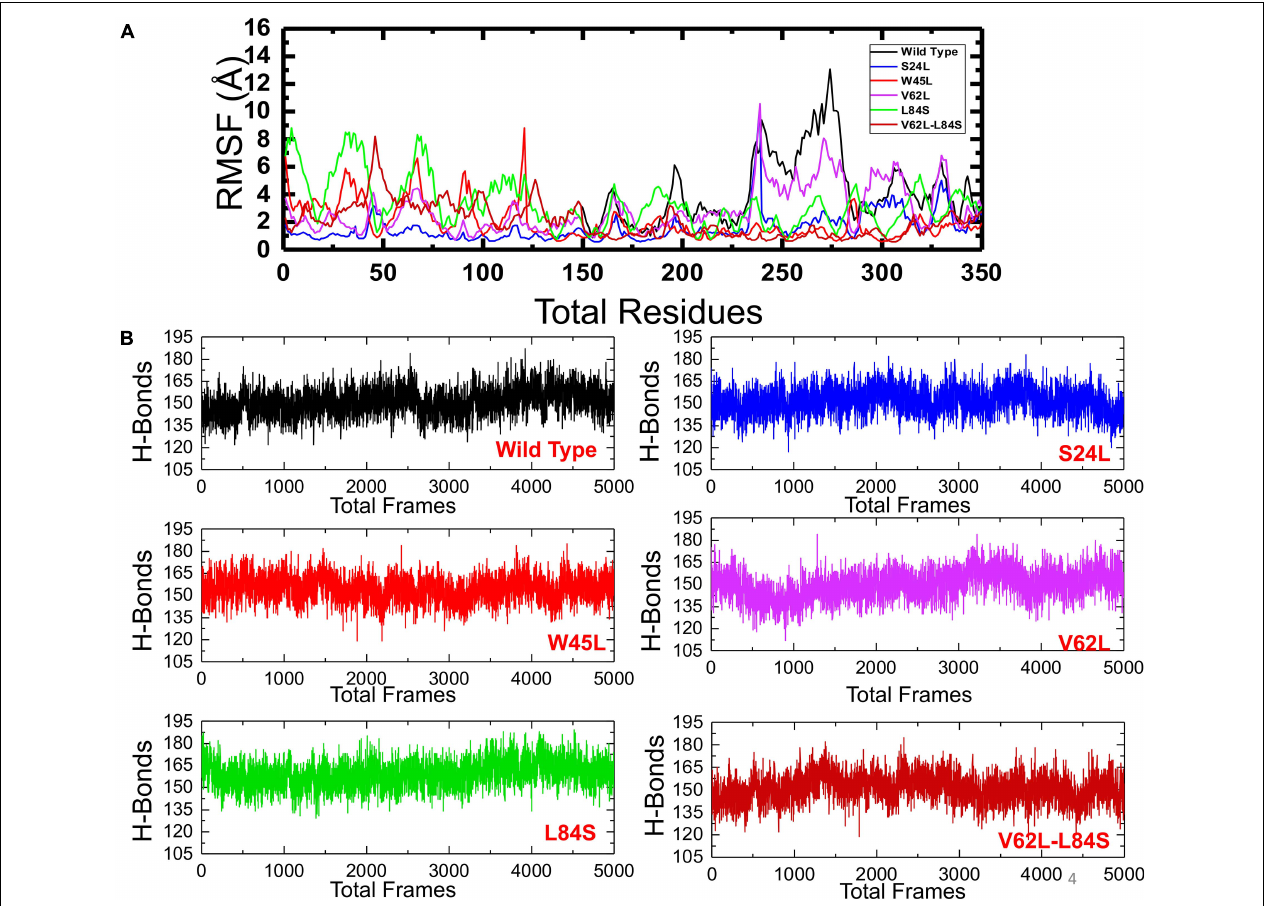
FIGURE 5 | The RMSFs and H-bonding graphs of all complexes. (A) The RMSFs of the ORF8 WT were shown in black, while the other mutants were given in different colors. RMSFs, root mean square fluctuation. (B) The H-bonding graph of the ORF8 WT was shown in black, while the other mutants were given in different